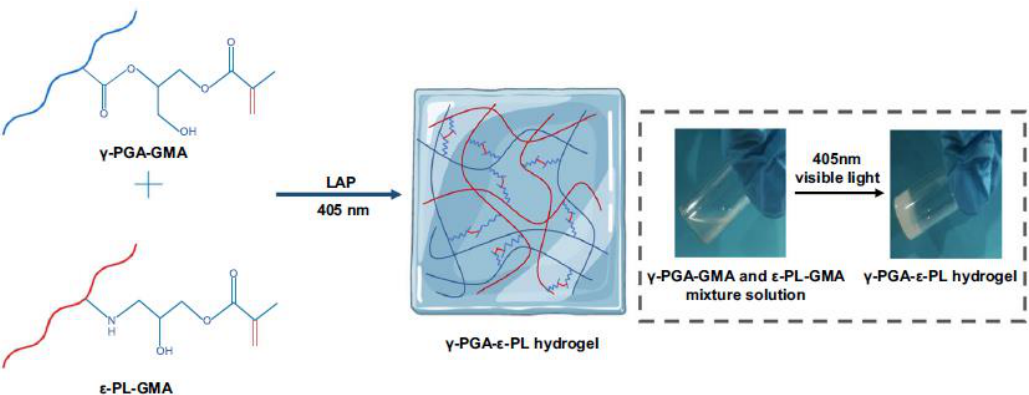
Figure 5. Schematic representation of light-polymerized hydrogel based on γ -poly(glutamic acid) ( γ -PGA)– ε -poly-L-lysine ( ε -PL) hydrogel synthesis. Reprinted with permission. Copyright 2021, NPG Asia Materials [41].